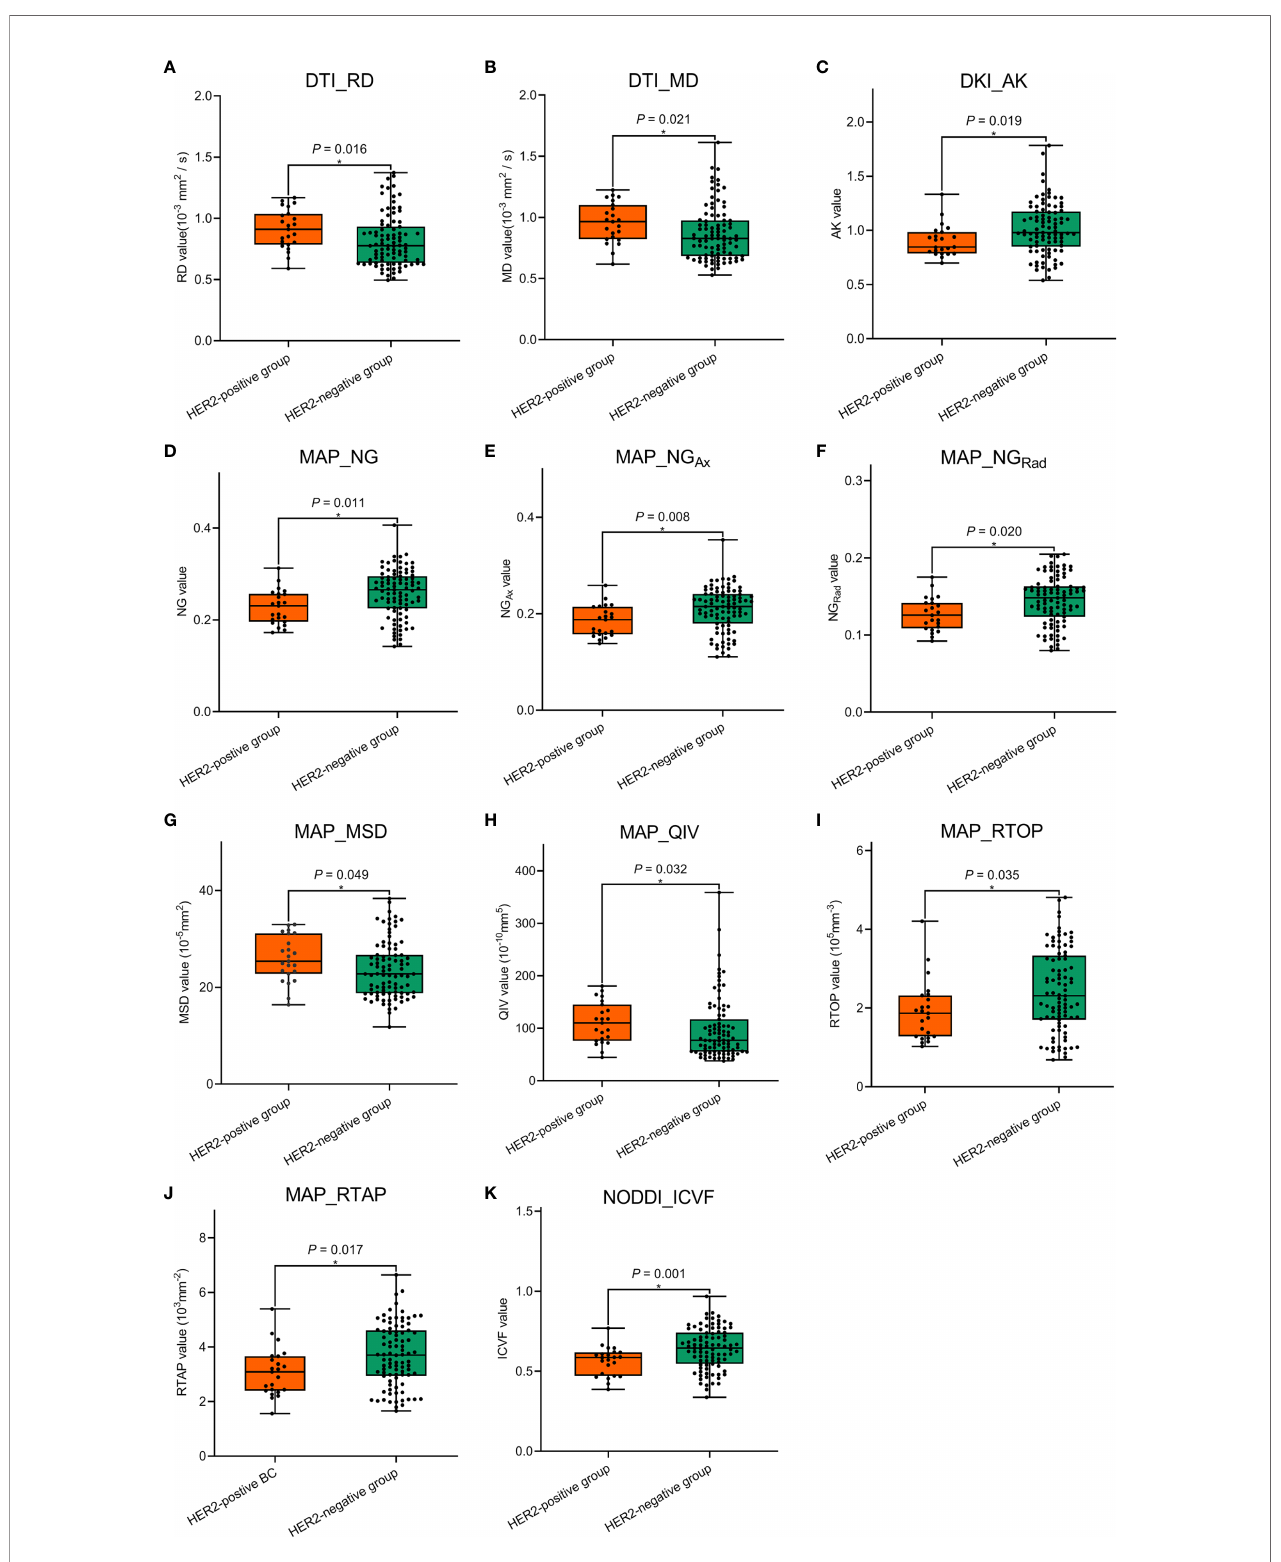
FIGURE 4 | Comparisons of the signi fi cant diffusion spectrum imaging (DSI) quantitative parameters (A – K) between the human epidermal growth factor receptor 2 (HER2)-positive group and the HER2-negative group in the derivation cohort. * The statistically signi fi cant level, p <